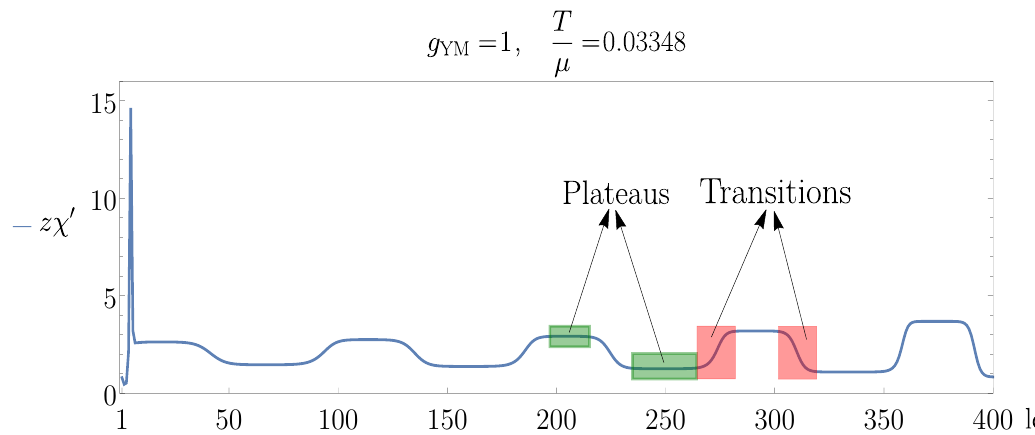
Figure 14. An example of the interior of the black hole demonstrating function zχ 0 for large z , at g YM = 1 and T/µ = 0 . 03348 . On this data we see that up to log z = 400 , there are five oscillations in zχ 0 . The different plateaus (two highlighted in green) of each oscillation correspond to a different n h and thus different Kasner universes. The transitions (two highlighted in red) detail how neighbouring Kasner universes